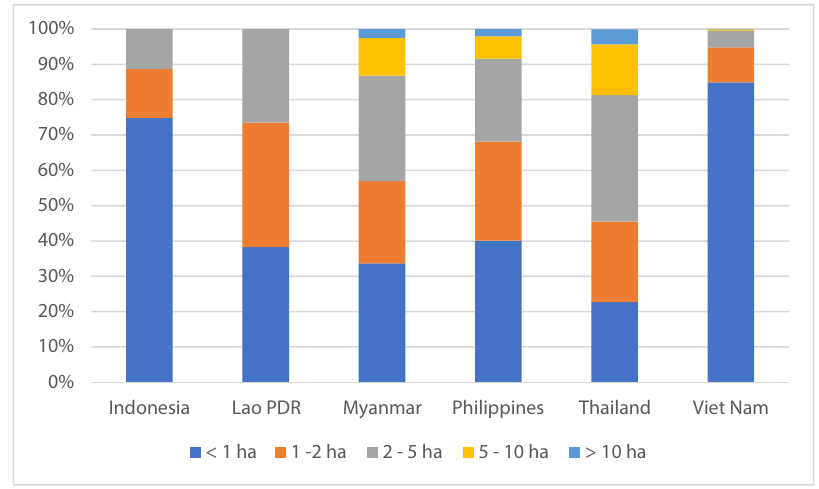
Figure 1: Distribution of farm size in Southeast Asia during the 2000s ( Lowder et al. 2014 )